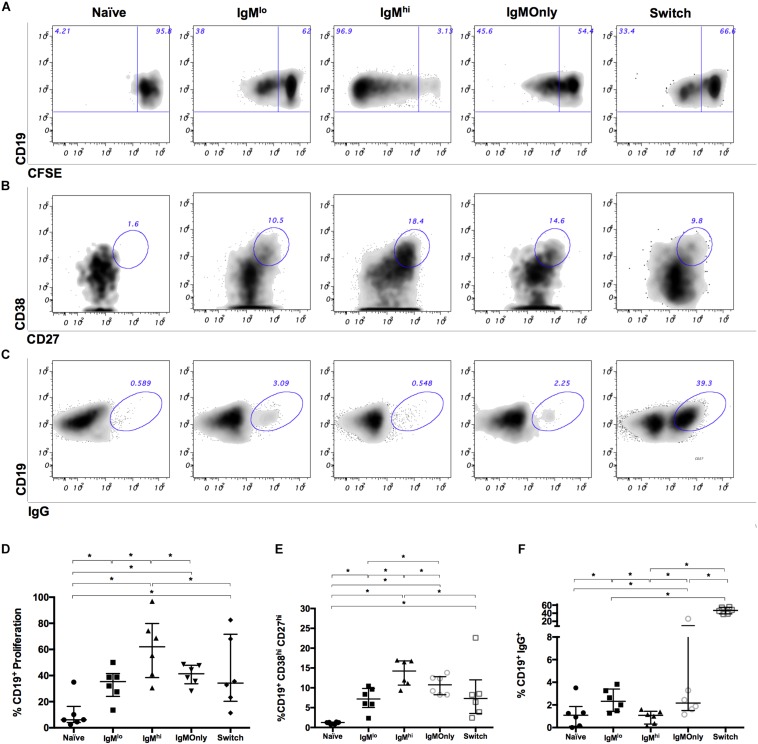
Proliferation, differentiation to ASC, and IgG expression of B cells subsets after ex vivo stimulation. 0.4 – 1.0 × 106 sorted B cells from healthy donors were stimulated with CpG and a cocktail of cytokines (IL-2, IL-6, and IL-10) together with irradiated fibroblasts for 3 days and evaluated by flow cytometry. Representative dot plots of (A) CFSE- proliferating B cells, (B) differentiation to ASC (CD38hi CD27hi), and (C) intracellular IgG expression. (D–F) summary of experiments presented in (A–C), respectively. Wilcoxon tests were used for evaluating differences among groups. Lines and error bars denote the median and interquartile range * denotes p < 0.05. n = 6.